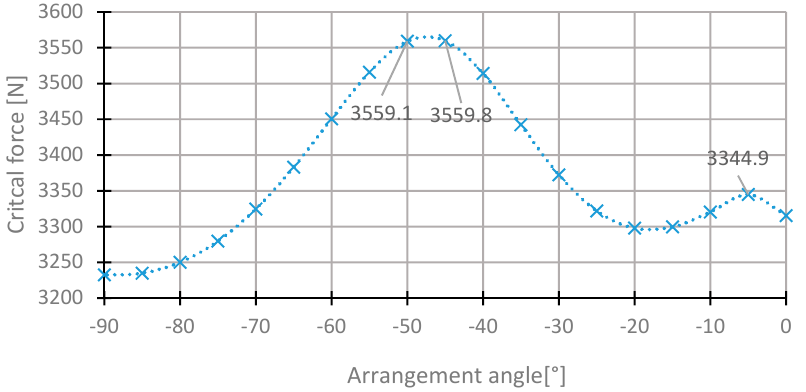
Figure 11. The critical force depending on the angle in the third laminate layer of the [45/ − 45/ − 45/45] arrangement for the change of the arrangement angle in the range from − 90° to 0°.